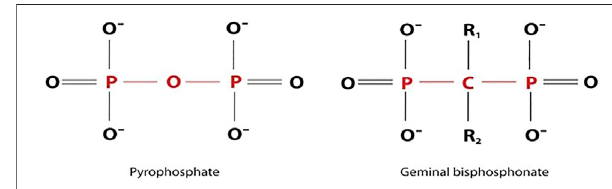
FIGURE 1 | A structural analogy of bisphosphonates and pyrophosphates